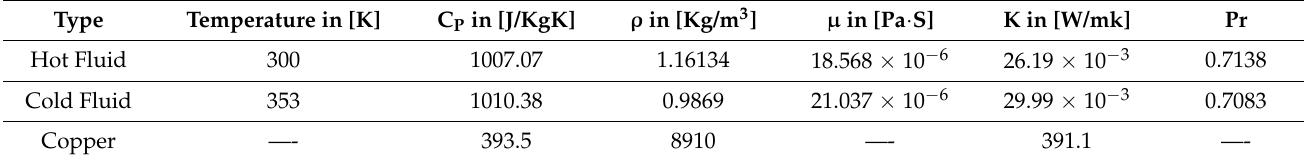
Table 2. Thermophysical properties.